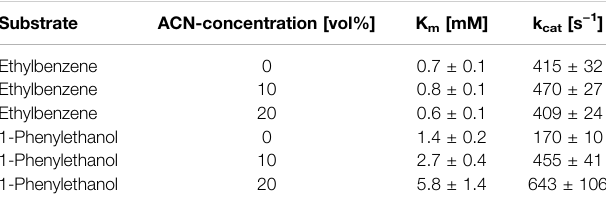
TABLE 1 | Effect of increasing acetonitrile (ACN) concentrations on the kinetic parameters of r Aae UPO toward the substrates ethylbenzene or 1- phenylethanol. Reaction conditions: [ethylbenzene or 1-phenylethanol] = 0.3 – 2 mM, [KPi, pH 7] = 10 mM, [acetonitrile] = 0 – 20 vol%, [r Aae UPO concentrated supernatant] = 8.4 nM, [H 2 O 2- concentration] = 1.7 mM; reaction time = 15 s, total volume 8 mL, room temperature, and triplicate